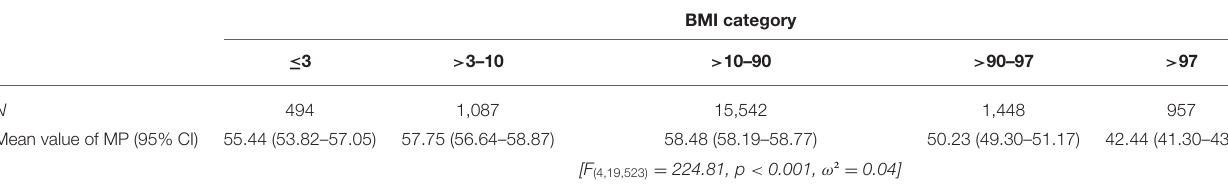
TABLE 3 | Mean value of MP in the different BMI